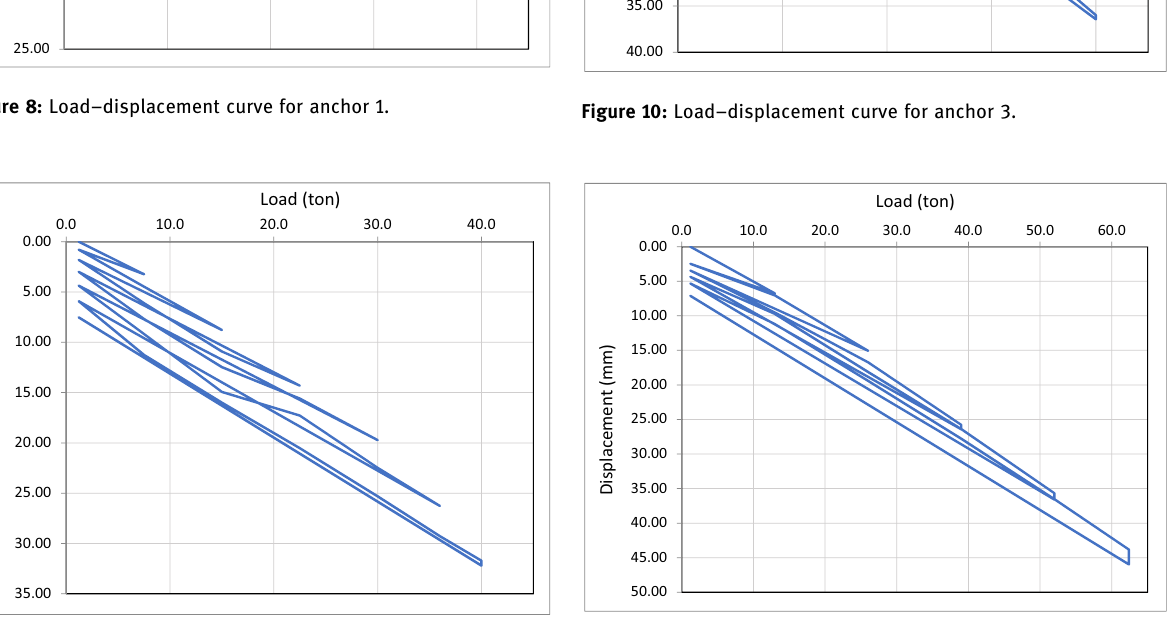
Figure 11: Load – displacement curve for anchor 309. Figure 9: Load – displacement curve for anchor 2.